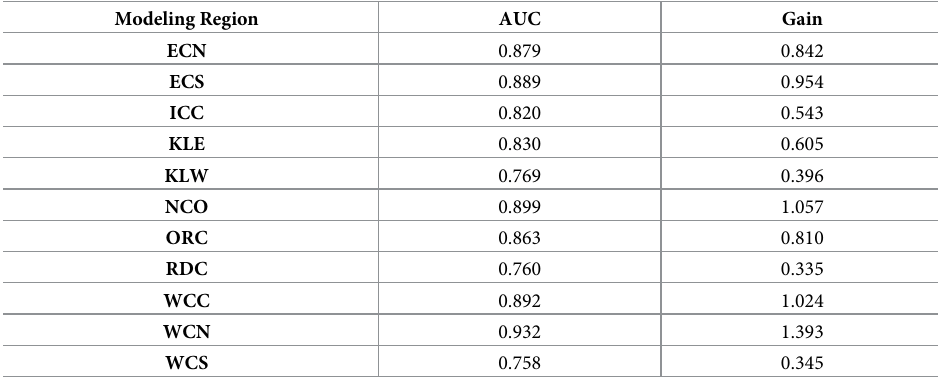
Table 6. Relative habitat suitability model evaluation statistics among 11 modeling